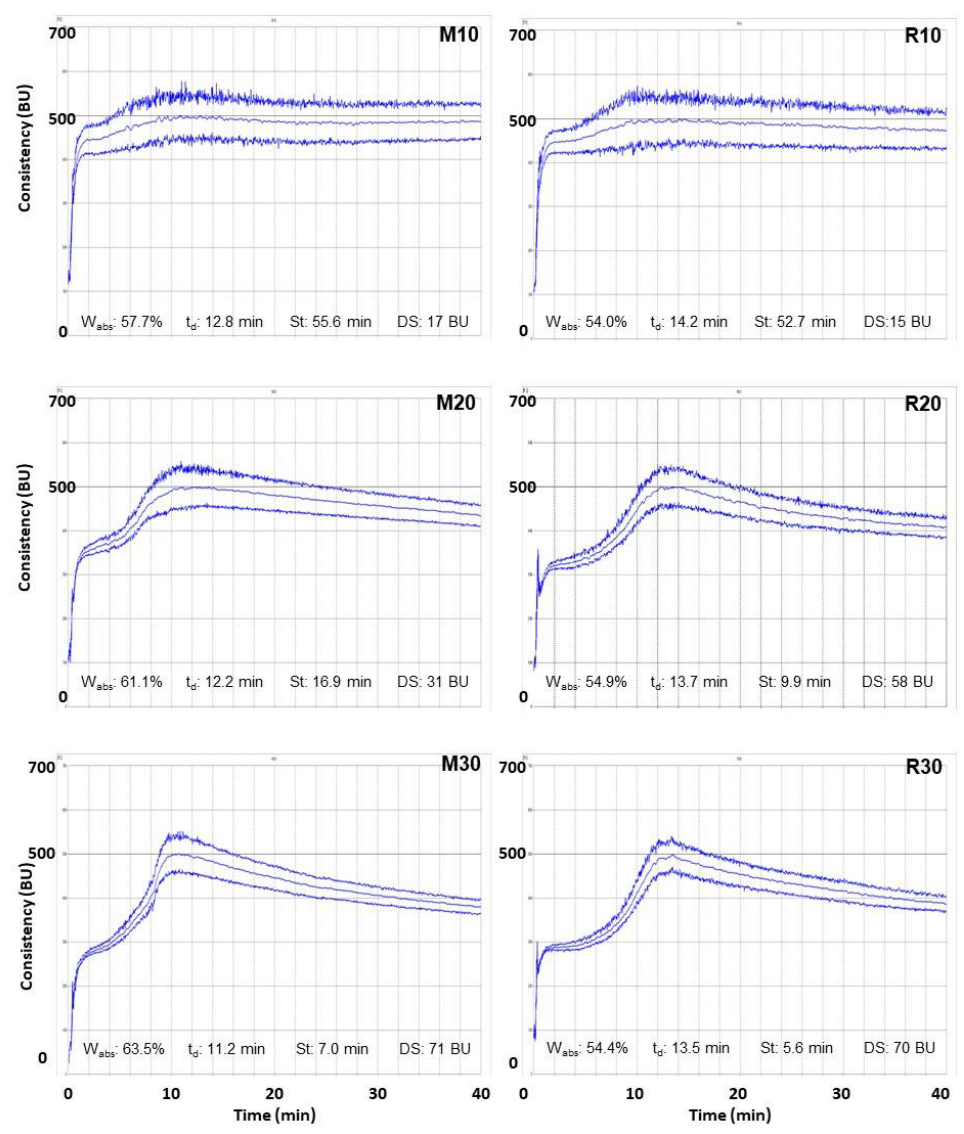
Figure 2. Farinograms of wheat flour complemented with Misak lupine flour: 10% (M10), 20% (M20) and 30% (M30); and with Rumbo lupine flour: 10% (R10), 20% (R20) and 30% (R30). W abs : water absorption; td: development time; St: stability; SD: softening degree. The Y -axis corresponds to the consistency (between 0 and 700 BU)” the marked line parallel to X -axis indicates 500 BU; the X -axis is the kneading time (up to 40 min) for all the graphs.